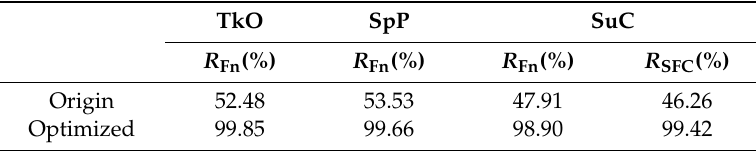
Table 8. Statistics results of candidate cycle